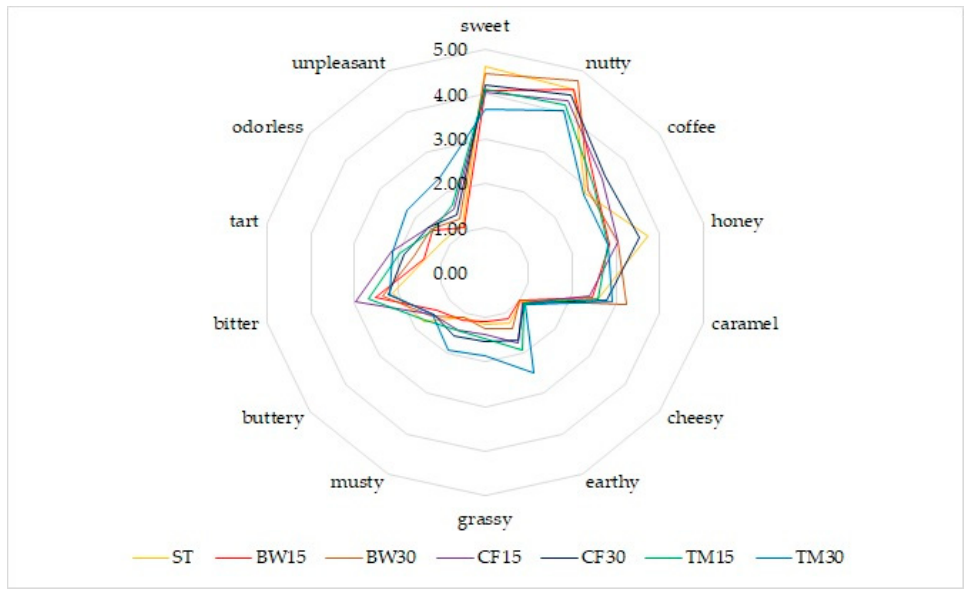
Figure 1. Organoleptic characteristics of bars—smell profile.